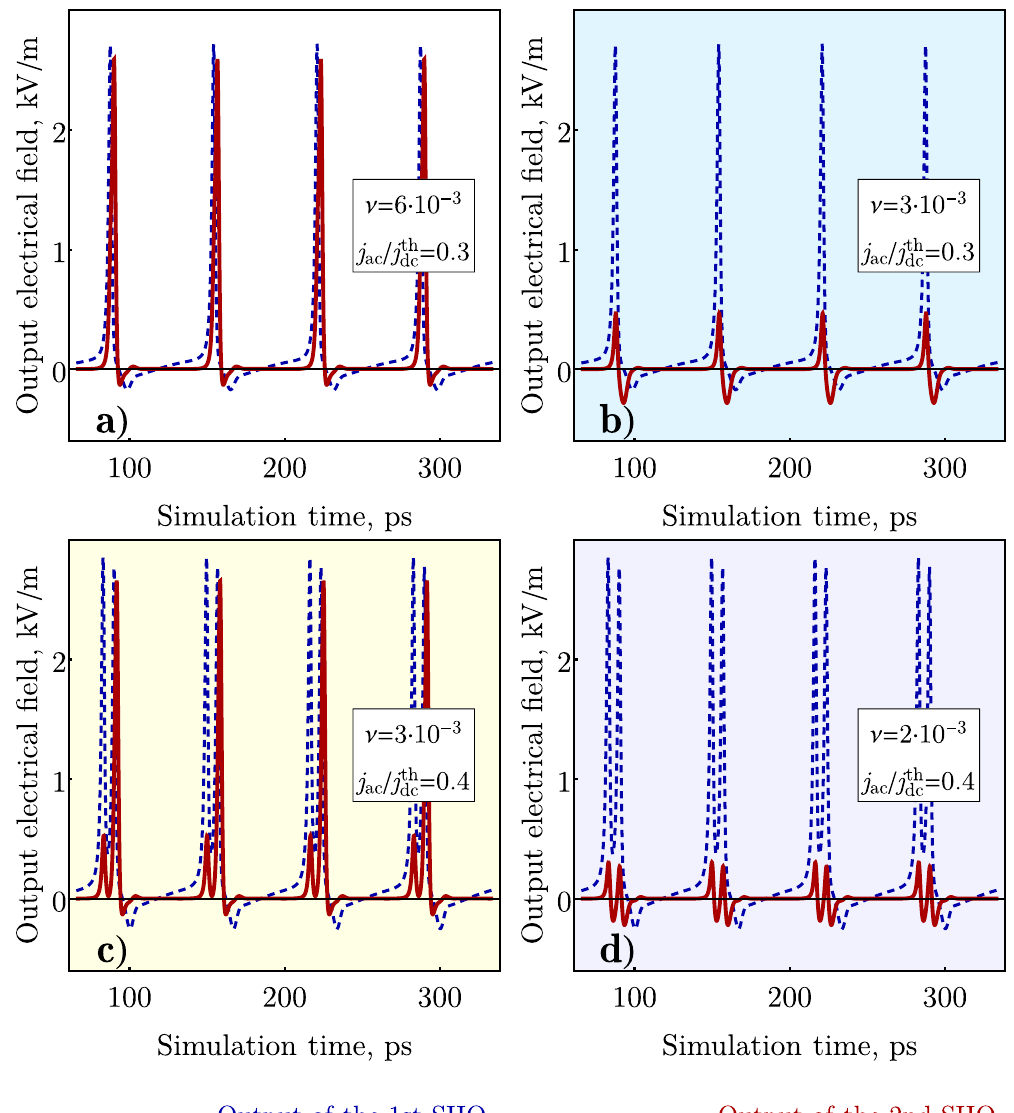
Figure 6. Numerical simulation of the operation of a network of two AFM SHO connected in a sequence for different values of the coupling coefficient between the SHOs and different modulation depths of a driving sinusoidal signal applied to the first (master)